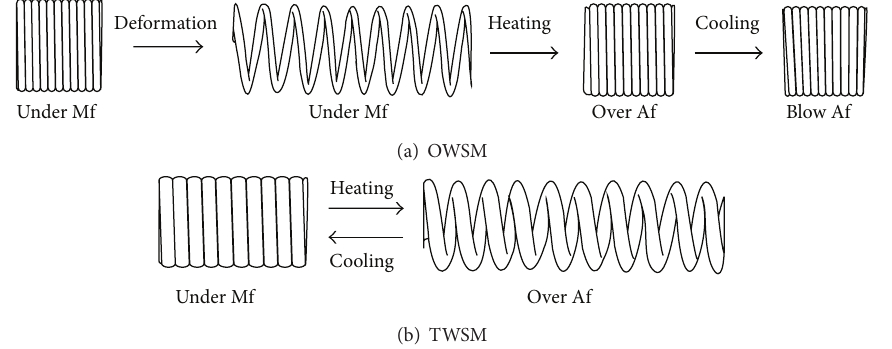
Figure 1: Two instructions of two-way memory training